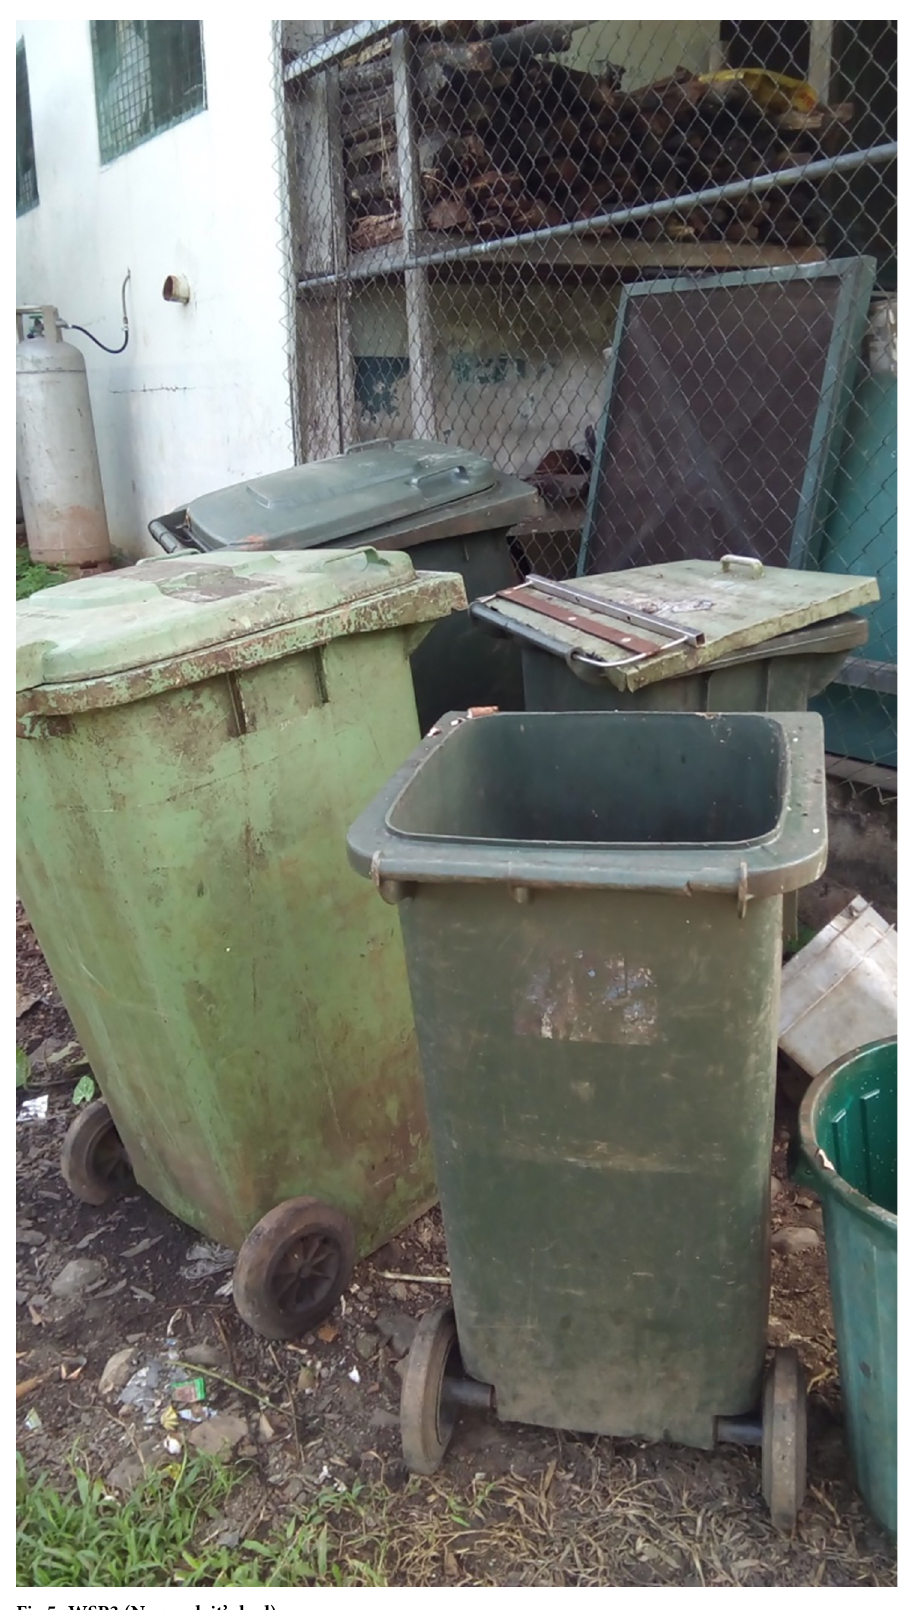
Fig 5. WSP3 (No good, it’s